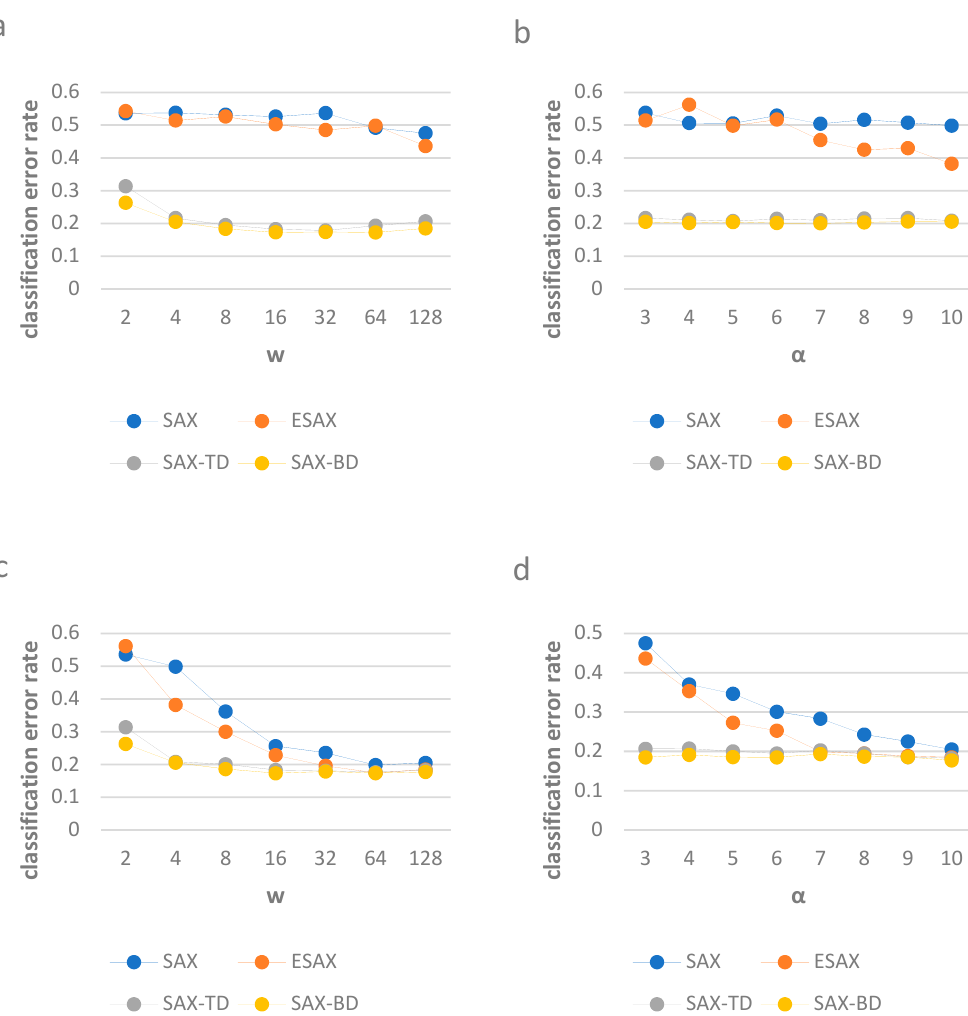
Figure 6. The SAX-BD algorithm is compared with other algorithms for accuracy. ( a – d ) represents a comparison between SAX-BD with Euclidean, SAX, ESAX, SAX-TD. The more dots above the red slash, the better performs of SAX-BD.